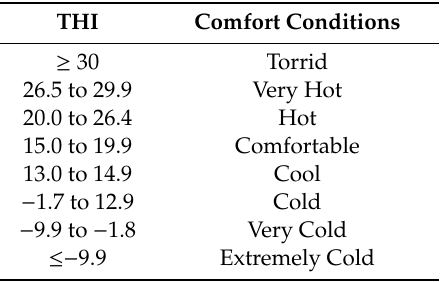
Table 6. Thom’s thermal discomfort index and comfort